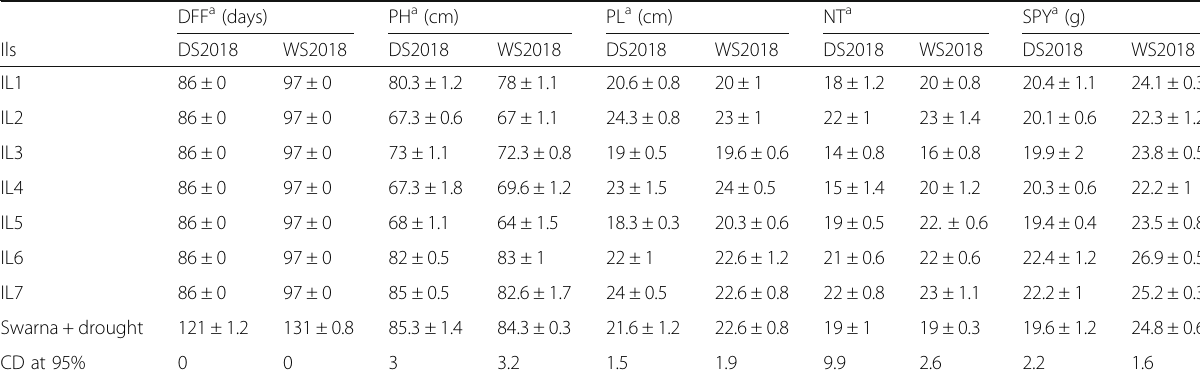
Table 2 Agronomic performance of introgression lines during DS2018 and